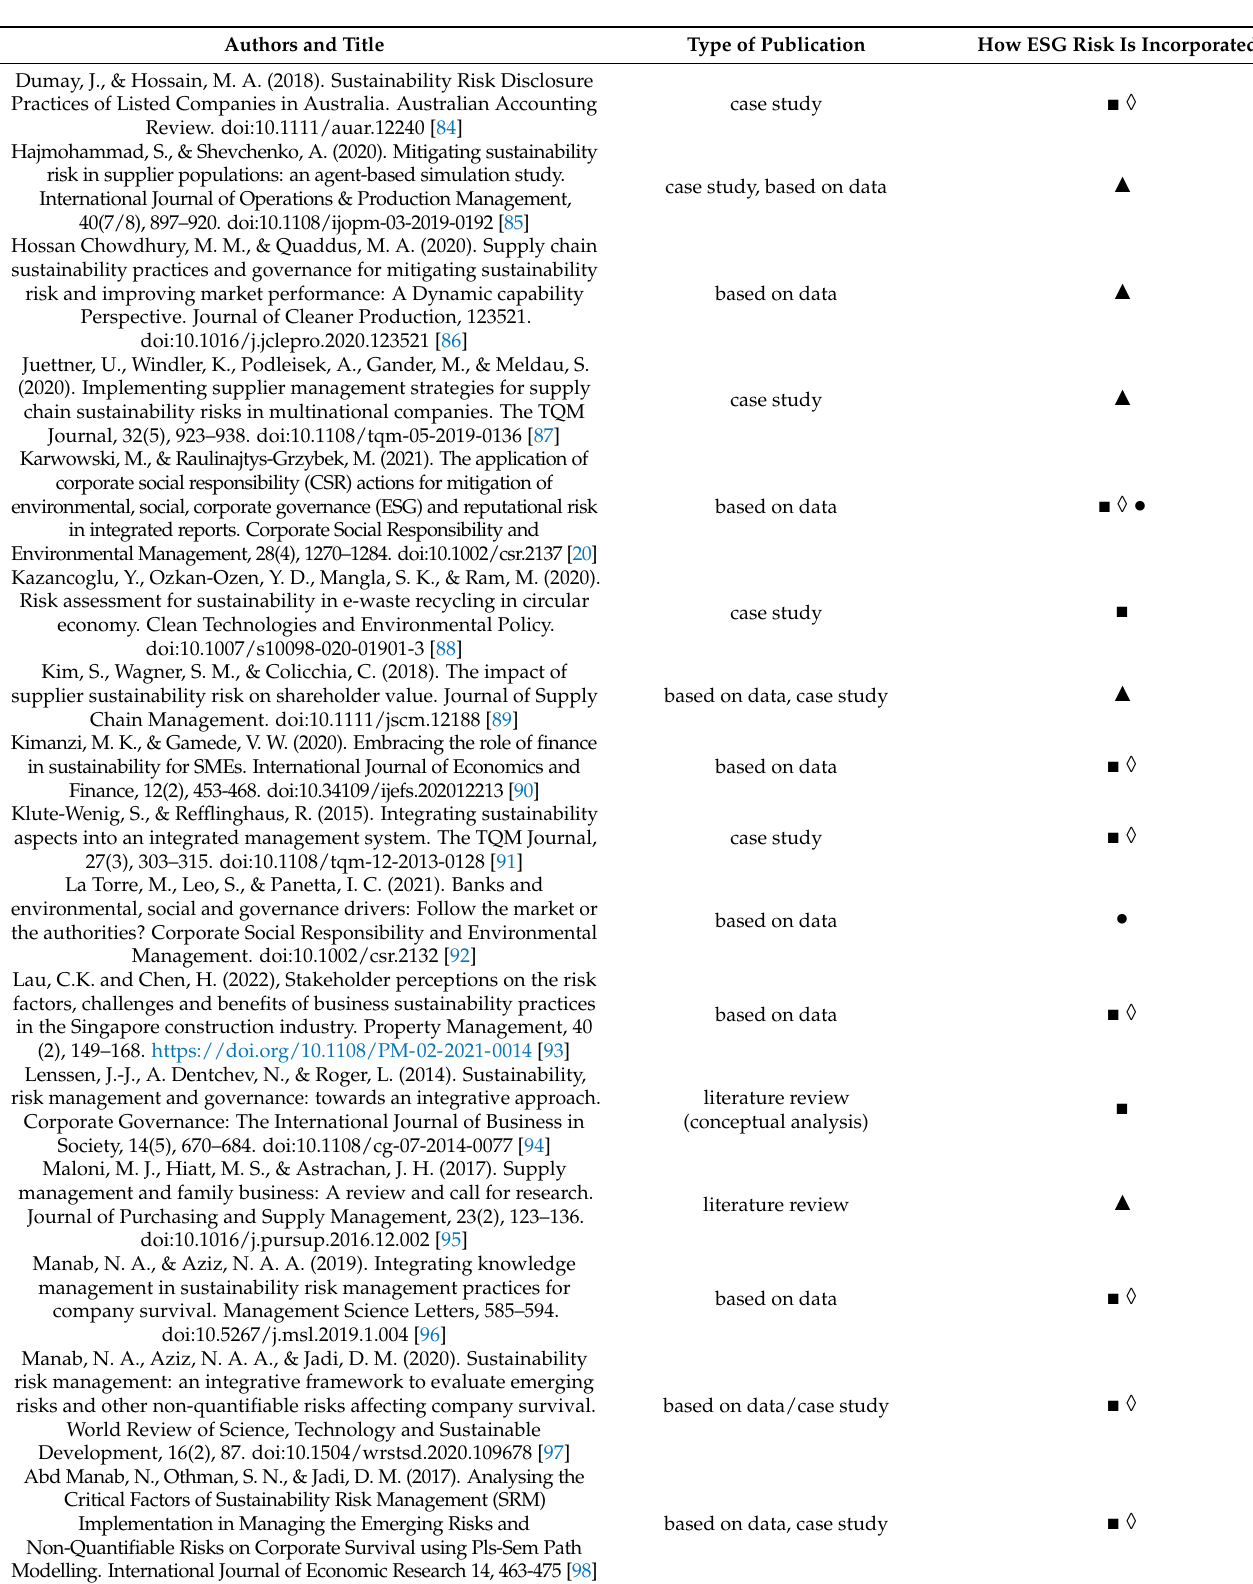
Table 17. List of publications with methods of incorporating ESG risk into business models Authors and Title